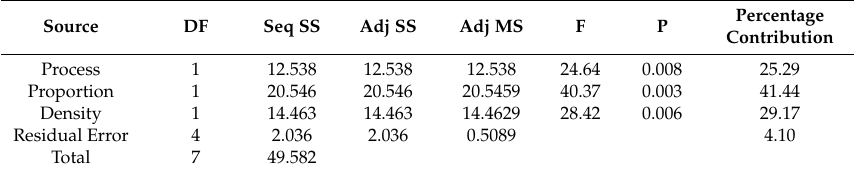
Table 5. ANOVA for SN ratios of electrical conductivity.